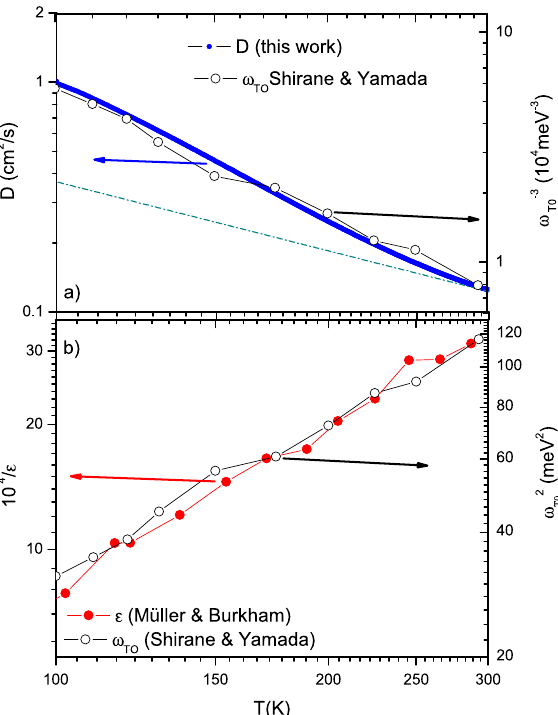
Fig. 6 Diffusivity, ferroelectric soft mode and permittivity. a Blue line consisting of dense solid circles represent the diffusion constant extracted from mobility. The dashed line represents a T − 1 tempera- ture dependence. Open circles represent the soft mode frequency, ω (cid:4) 3 according to ref. 54. The two quantities scale with each other in (cid:5) (cid:6) TO this temperature range D / ω (cid:4) 3 . b The inverse of electric TO permittivity, ϵ (cid:4) 1 36 and ω 2 in the same temperature range. The TO scaling is ϵ (cid:4) 1 / ω 2